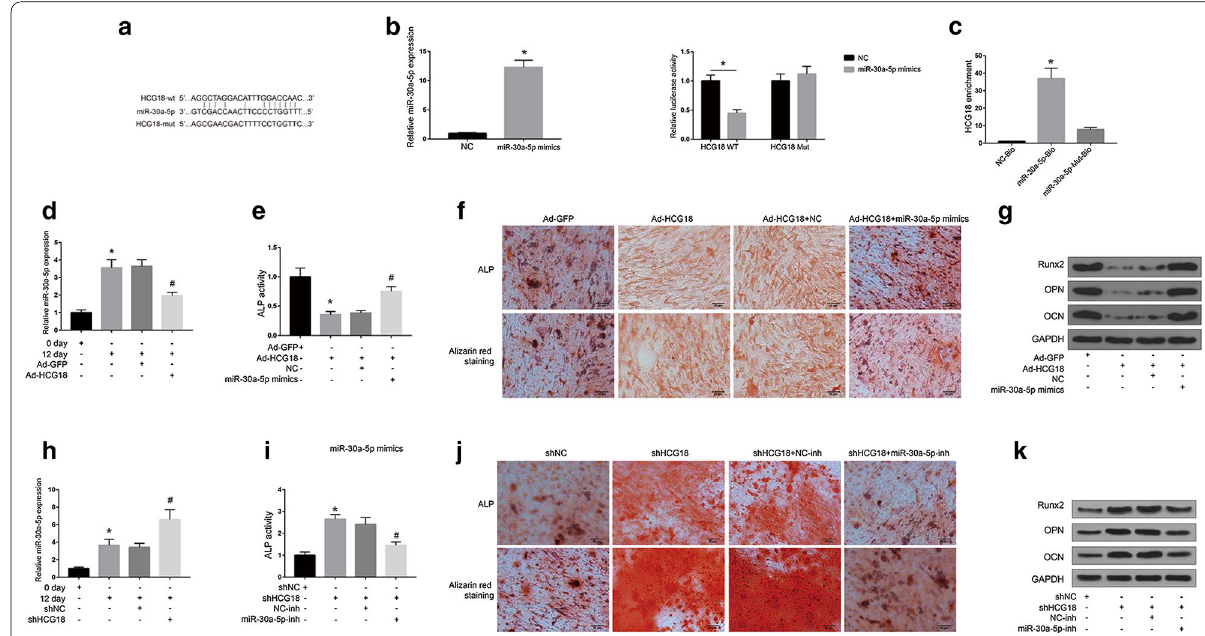
Fig. 3 Effect of HCG18 and miR-30a-5p on osteogenic differentiation of BMSCs. a Putative binding sites for HCG18 and miR-30a-5p. b Left panel, expression of recombinant adenovirus transfected with HCG18. Right panel, luciferase activity of HCG18-wt and HCG18-mut in HEK-293T cells treated with miR-665 mimic or NC. c RNA pull-down assay indicated that HCG18 could be enriched by biotin-labelled miR-30a-5p but not biotin-labelled miR-30a-5p mutant type. d HCG18 overexpression inhibited miR-30a-5p expression in OP-BMSCs. e ALP activity assay and f ALP staining and Alizarin Red S staining were performed on OP-BMSCs to investigated the effects of HCG18 and miR-30a-5p co-transfection on the osteogenic differentiation of OP-BMSCs. g Determination of the expression of specific markers for osteogenic differentiation (Runx2, OCN, OPN) of OP-BMSCs co-transfected with HCG18 and miR-30a-5p. h Knockdown of HCG18 promoted miR-30a-5p expression in OP-BMSCs. i ALP activity assay and j ALP staining and Alizarin Red S staining were performed on OP-BMSCs to investigate the effects of shHCG18 and miR-30a-5p-inhibitor co-transfection on the osteogenic differentiation of OP-BMSCs. k Determination of the expression of specific markers for osteogenic differentiation (Runx2, OCN, OPN) of OP-BMSCs co-transfected with shHCG18 and miR-30a-5p-inhibitor. * P < 0.05. The OP-BMSCs were from one human